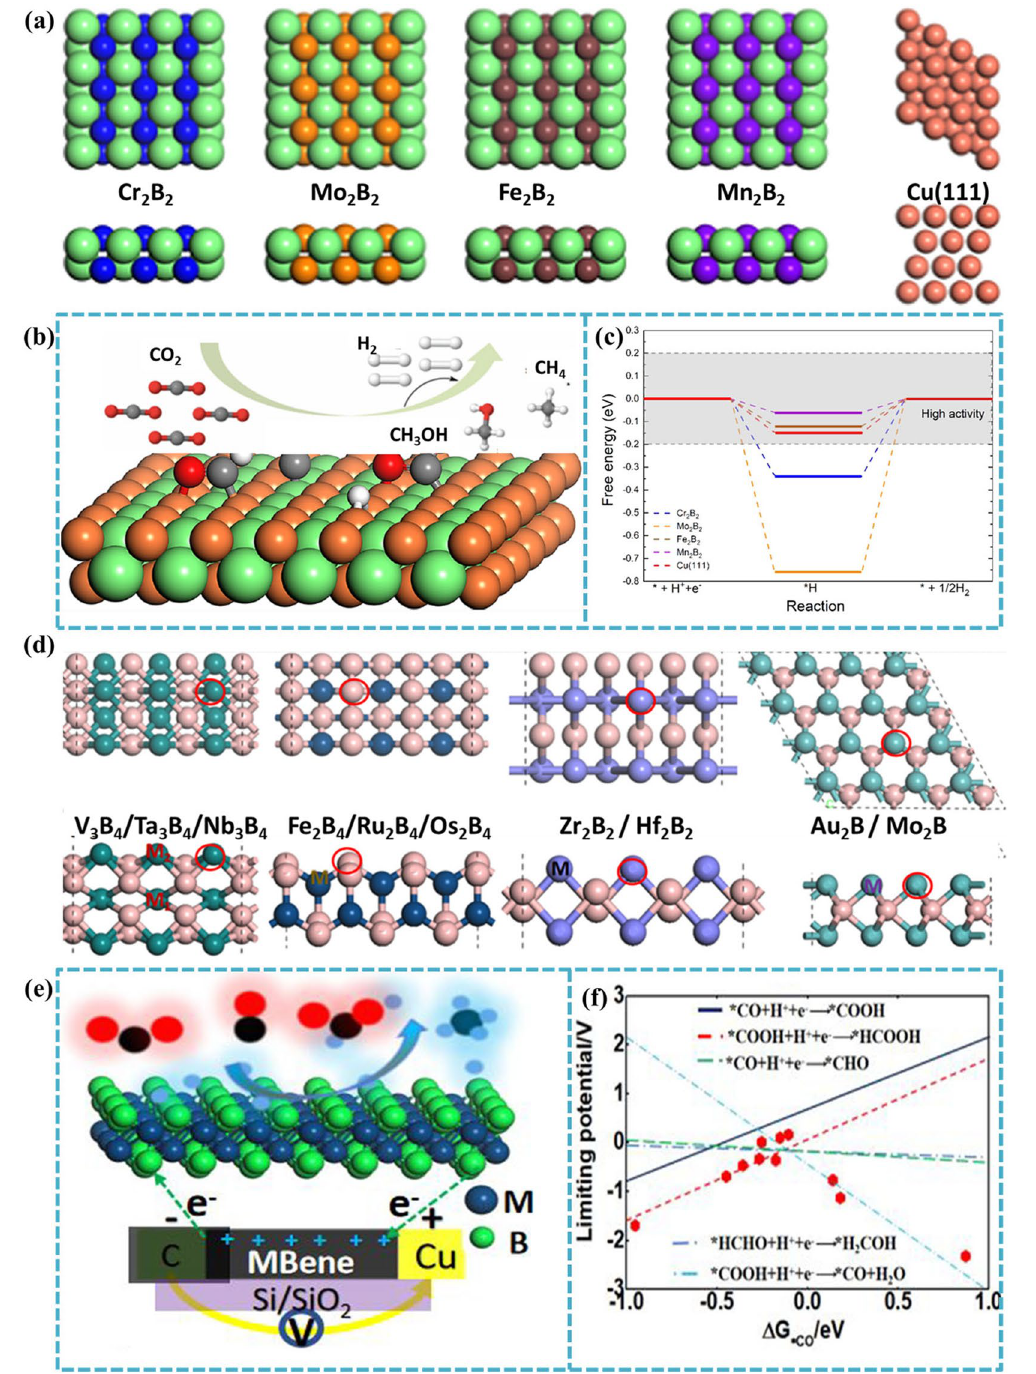
Fig. 14 a Optimized structures of Cr 2 B 2 , Mo 2 B 2 , Fe 2 B 2 , Mn 2 B 2 , and the Cu(111) surface. b Schematic diagram of the reaction for the elec- troreduction of CO 2 RR on 2D M 2 B 2 MBenes. c Relative free energy diagrams of HER on MBenes and Cu(111). Reproduced with permission from Ref. [207]. d Top views (upper) and side views (lower) of different types of MBene structures, the red circles represent the active sites